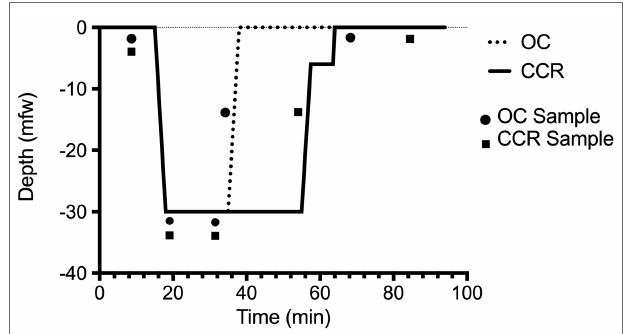
FIGURE 1 | Dive profile. Open-circuit (OC) depth of 30 mfw for 20 min in a pool environment (Nemo33, Brussels, Belgium). Closed-circuit rebreather (CCR) depth of 30 mfw for 40 min. The dive was made with a constant oxygen partial pressure of 1.3 bar on an air diluent providing an EAD of 24.2 mfw. The two depth-time profiles are embedded within accepted “no- decompression limits” (NAVSEA,